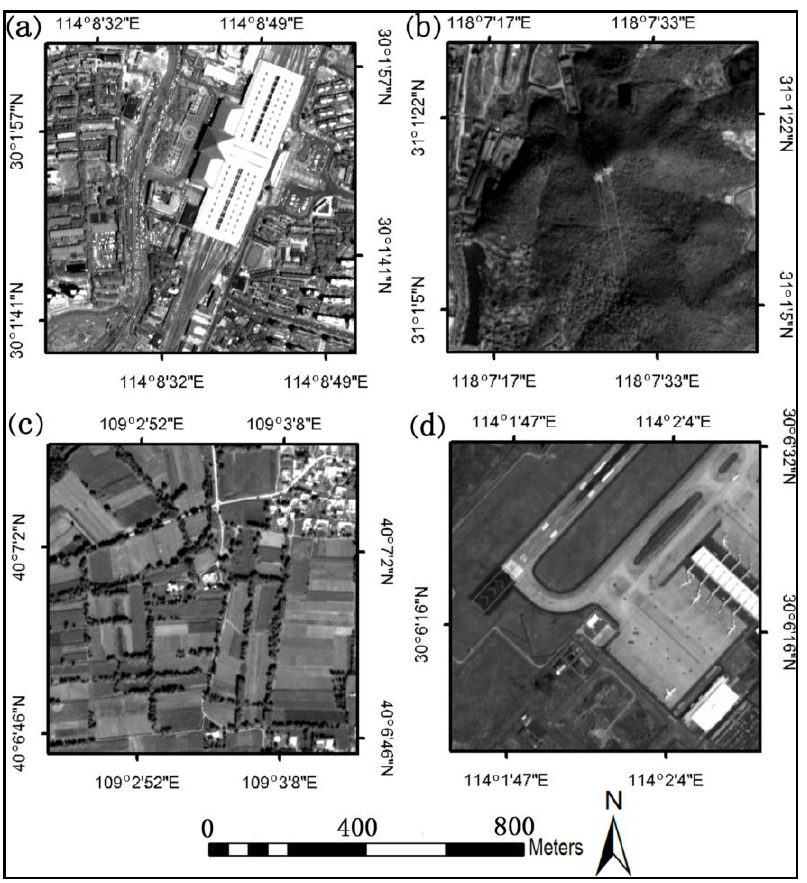
Figure 7. ZY-3 SC nadir (NAD) images in different areas. ( a ) A railway station of Wuhan,